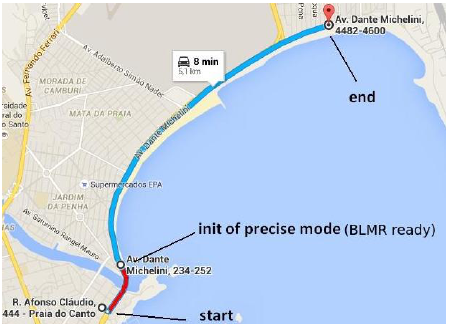
Figure 30. Urban road chosen for the experimental